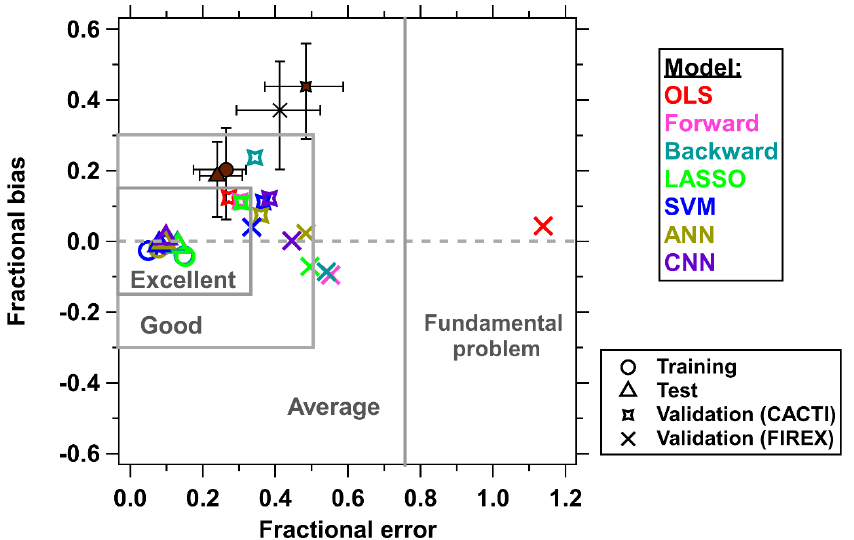
Figure 3. Fractional bias against fractional error for different combinations of datasets and data analytical approaches. When deriving the points with error bars, the “standard” MAC BC from Bond and Bergstrom [6] is used as predicted MAC BC , and “true” MAC BC is used as desired output of MAC BC .